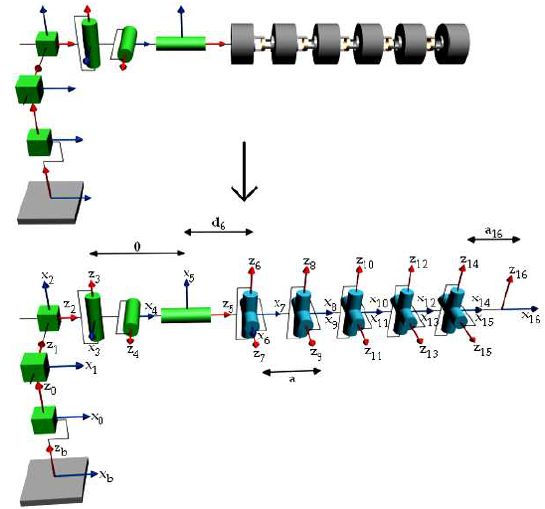
Figure 3: The degrees of freedom for the snake robot. The earth-fixed VSOP in conjunction with the snake robot is shown at the top. The coordinate systems mounted on the bottom structure have been placed in accordance with the Denavit-Hartenberg convention.